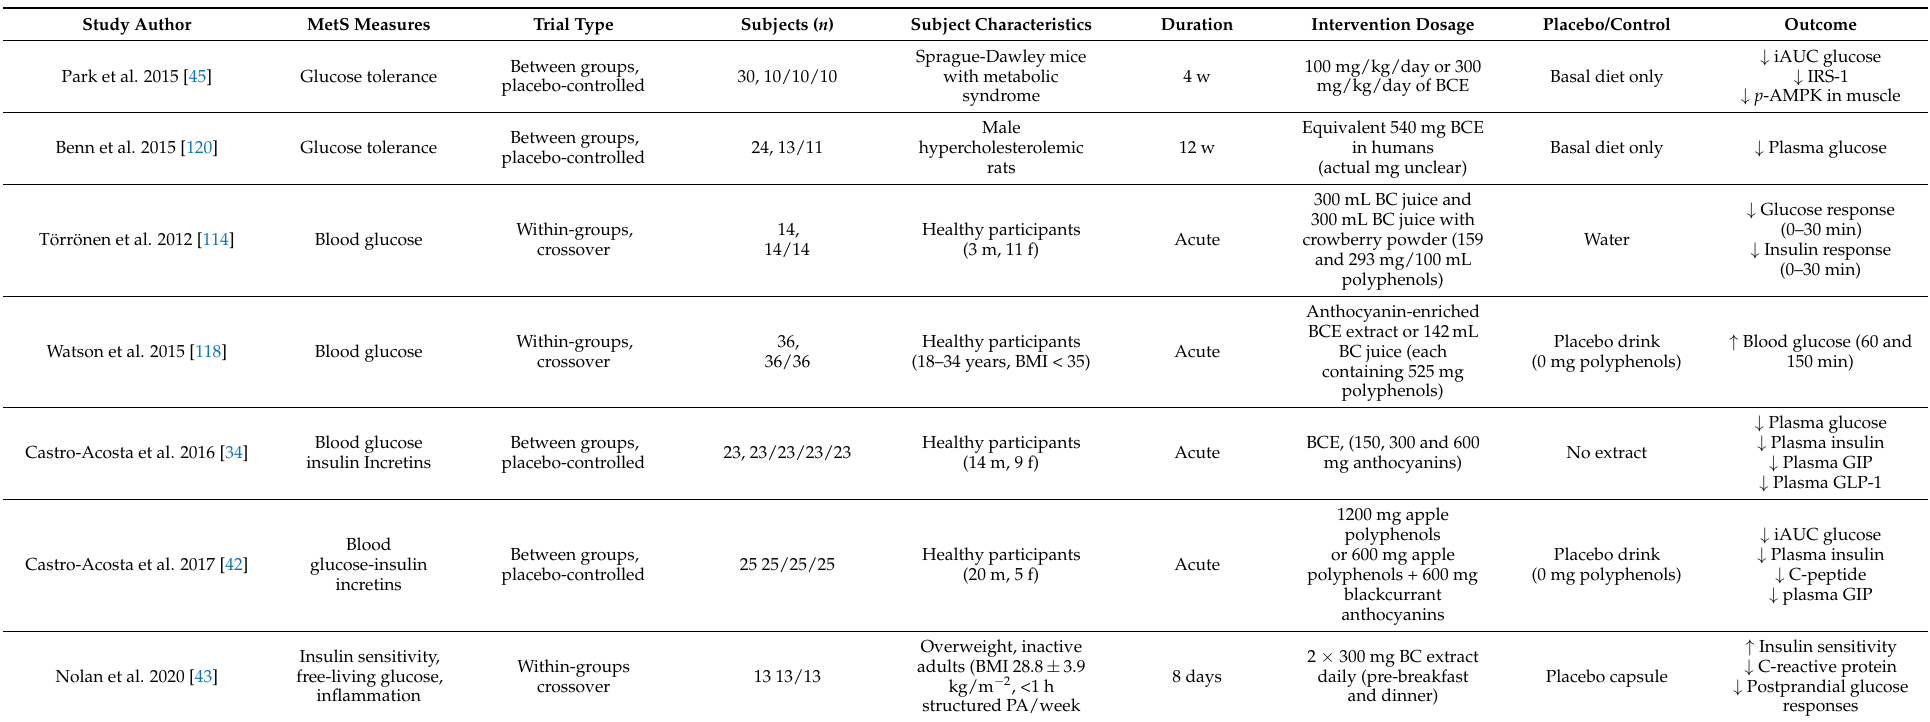
Table 6. Details of trials investigating blackcurrant juice and extracts on glucose